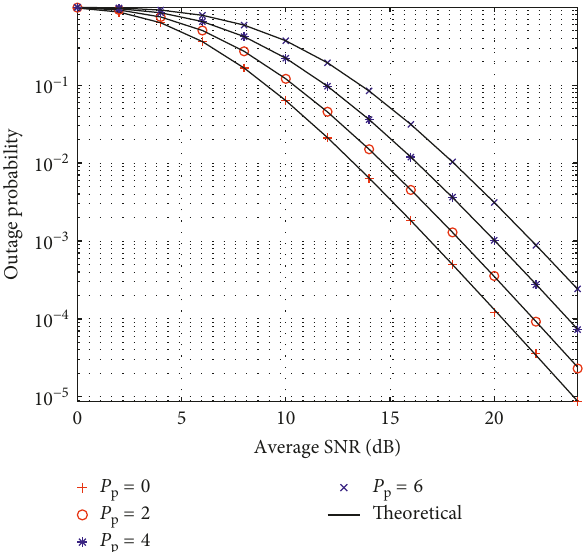
Figure 4: Outage probability for single power